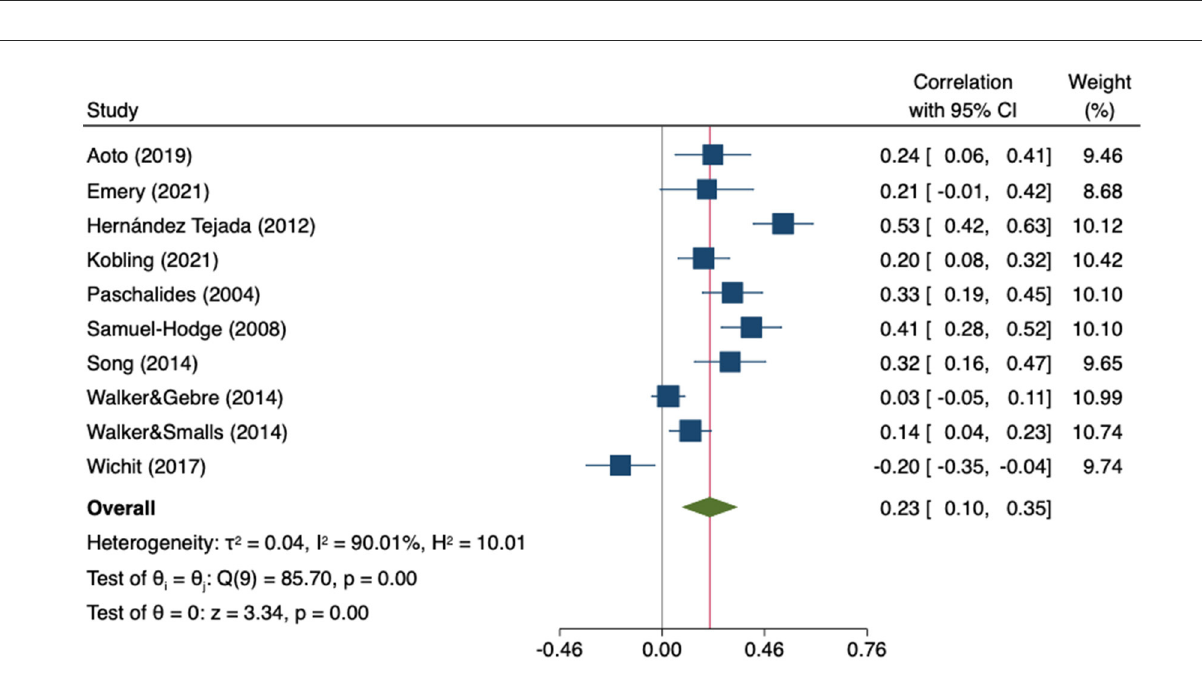
indicators on affective symptoms and QoL but also to assess causal associations. Moreover, variables potentially modifying the association between empowerment-related constructs and affective outcomes and QoL remain unclear and require further